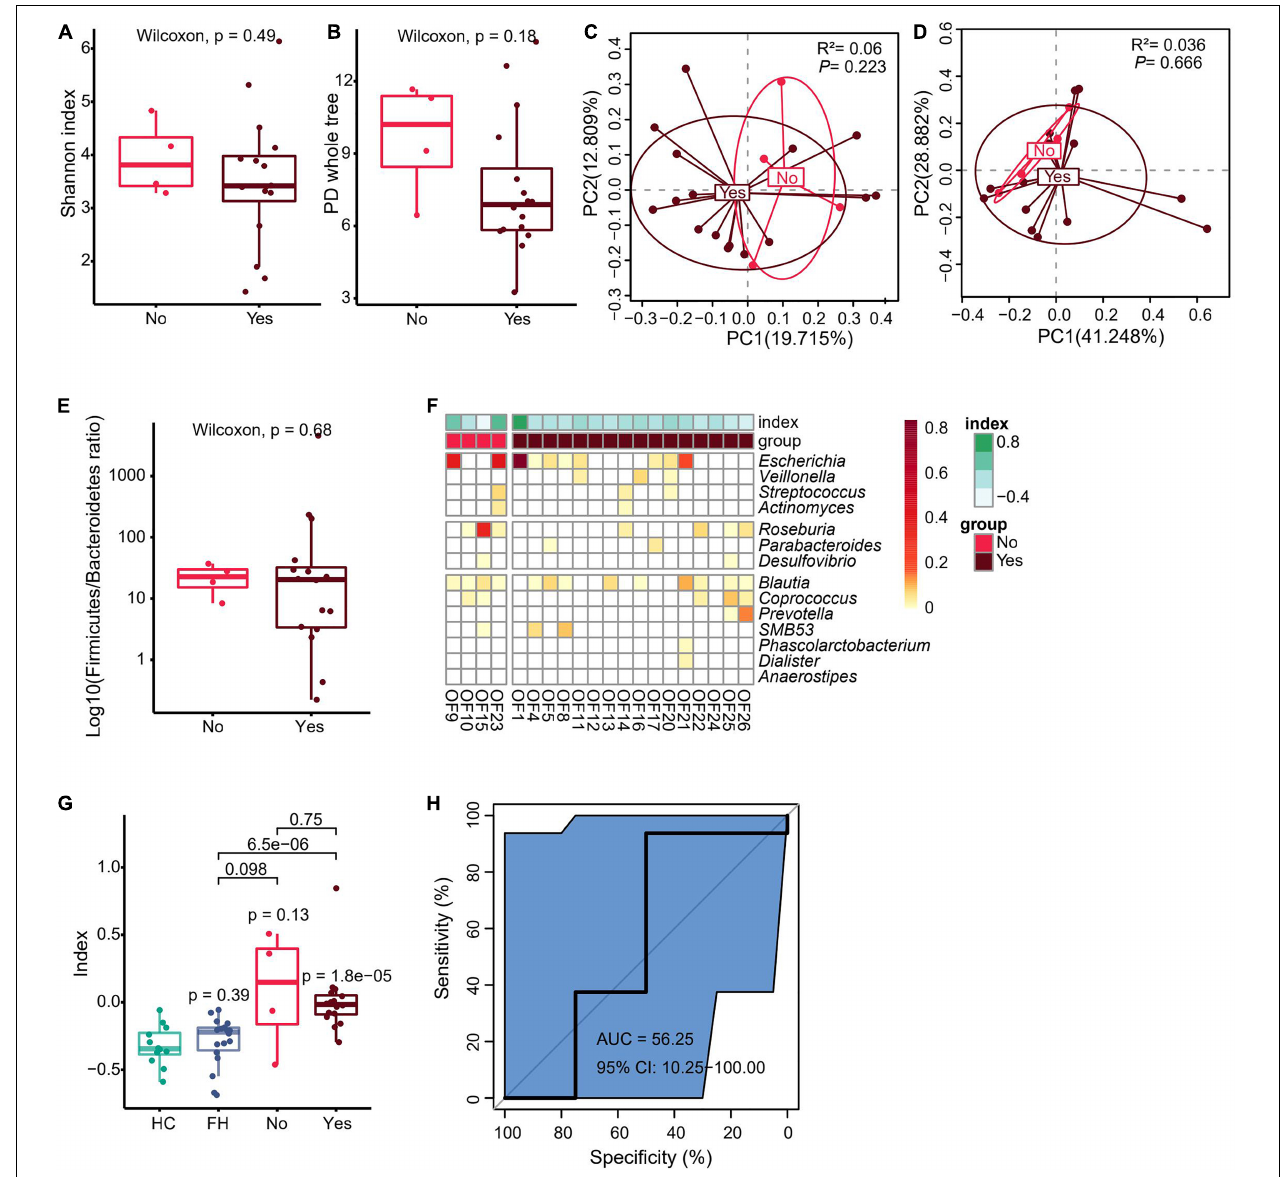
FIGURE 3 | Fecal microbiota composition in relation to visible pus or sinus tract in FRI group. (A) α Diversity indicated by Shannon’s diversity index. (B) α Diversity indicated by PD whole tree index. (C) PCoA based on Unweighted UniFrac distance. (D) PCoA based on weighted UniFrac distance. (E) The Firmicutes to Bacteroidetes ratio. (F) Bacteria genera for dysbiosis index building. (G) The dysbiosis index (HC vs. FH vs. Yes vs. No). (H) AUC showing diagnostic accuracy in judgment of sinus tract or pus before operation in FRI group based on gut microbiota composition (Yes vs. No). “Yes” for FRI subgroup with sinus tract or pus before operation and “No” for FRI subgroup without sinus tract or pus before